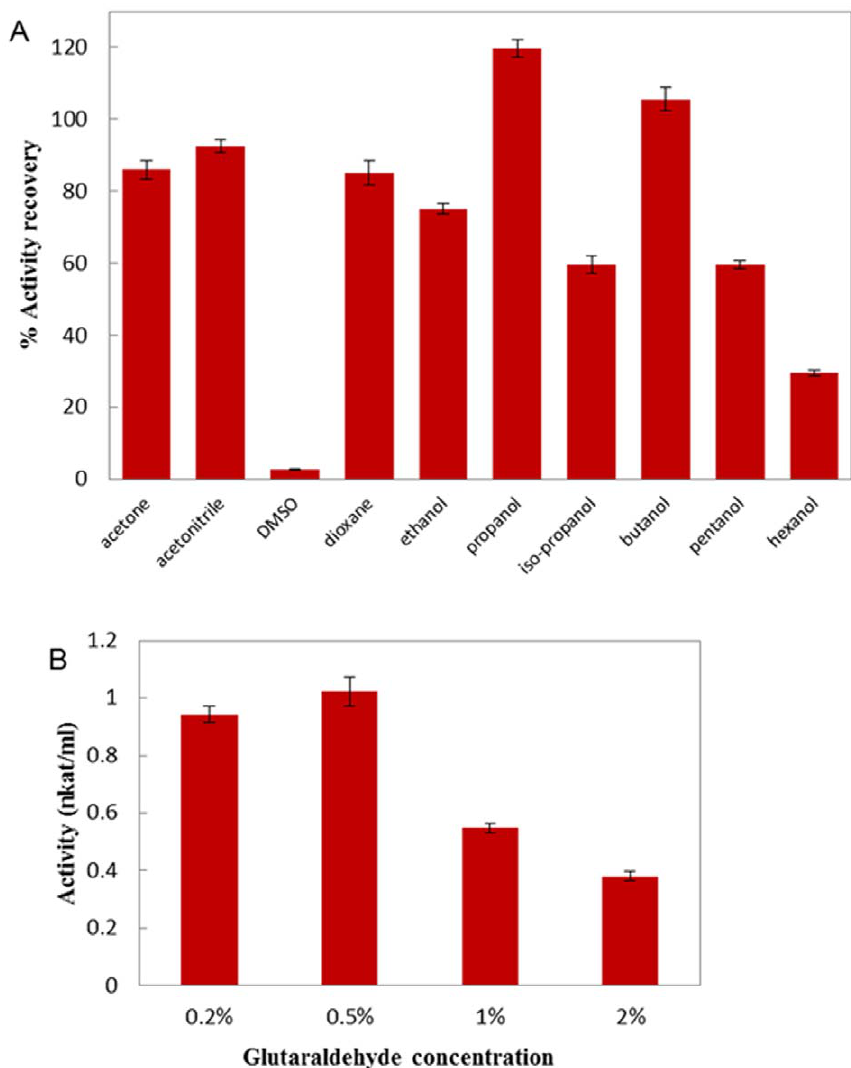
Figure 4. Preparation of CLEAs from PEG phase. (A) Precipitant screen. (B) Glutaraldehyde concentration screen.